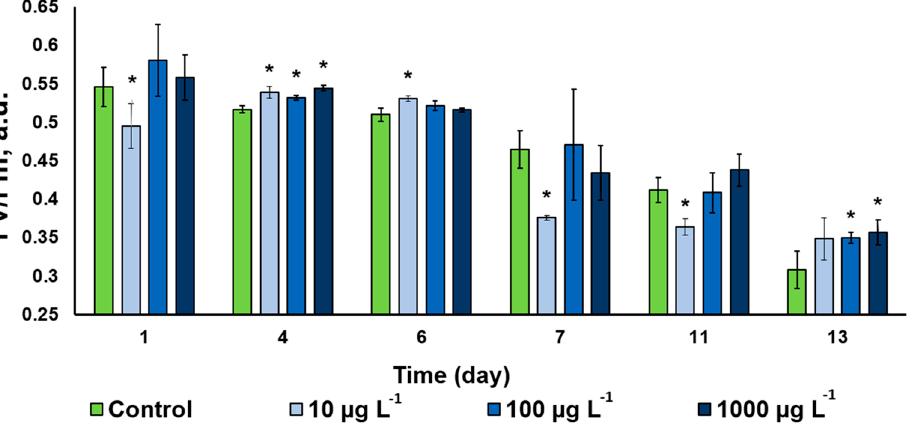
Figure 7. Changes of the Fv / Fm parameter in the of Desmodesmus sp. incubated with different CuO-NP concentrations. (Values significantly differing from the control are marked with an asterisk, *).